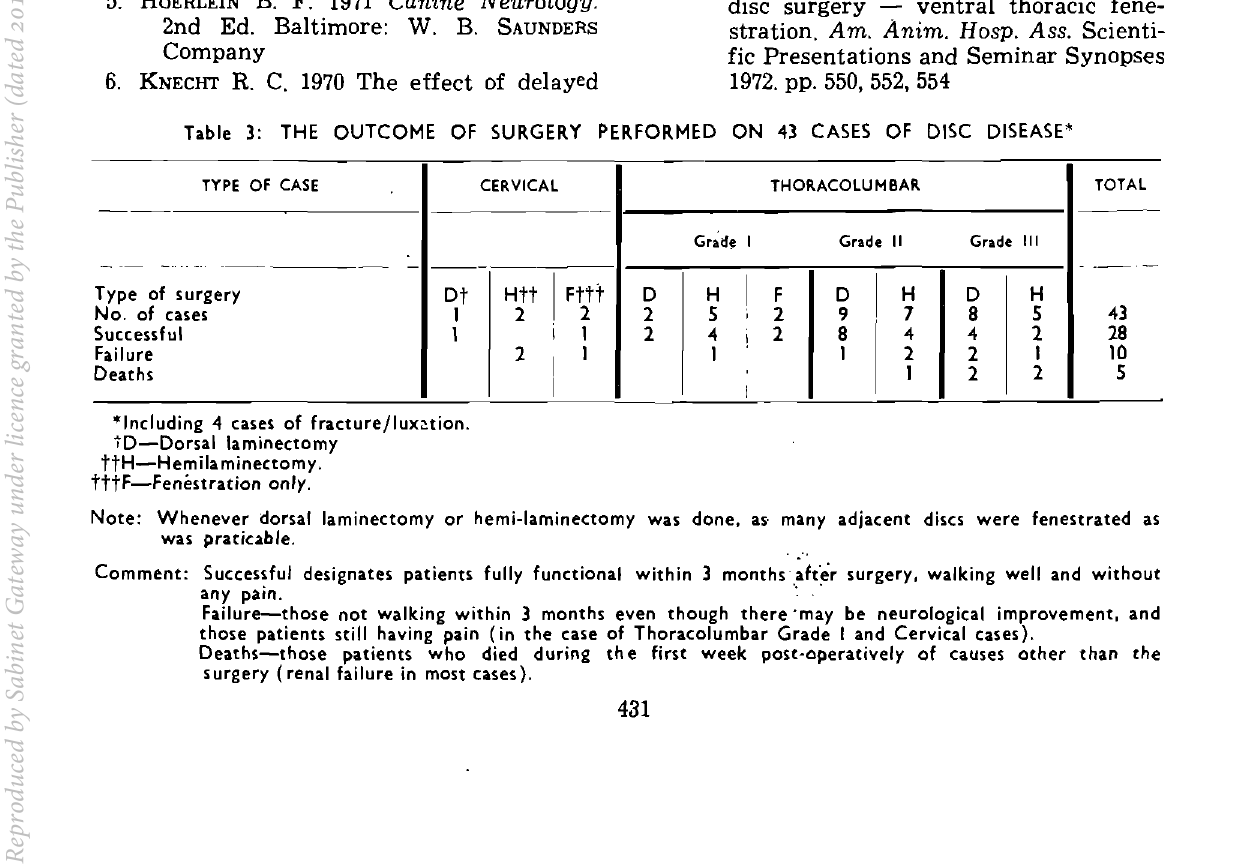
Table 3: THE OUTCOME OF SURGERY PERFORMED ON 43 CASES OF DISC DISEASE' TYPE OF